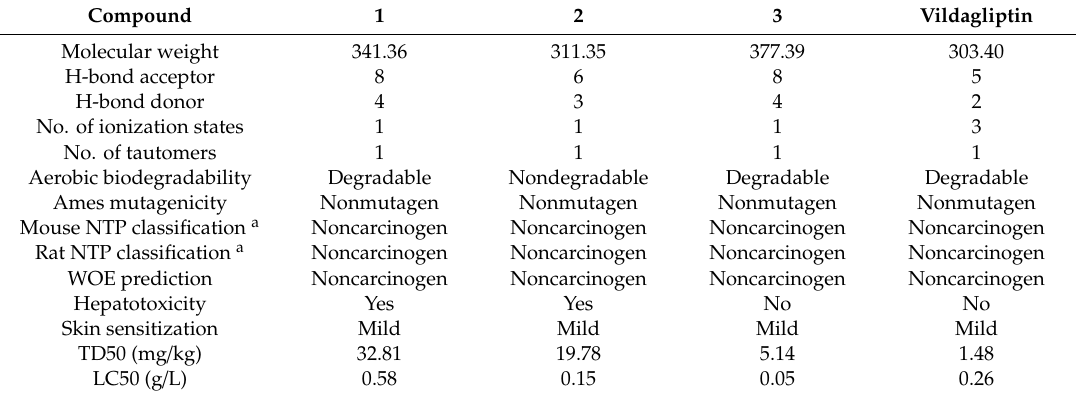
Table 4. Chemical information and toxicity properties of compounds 1 – 3 and